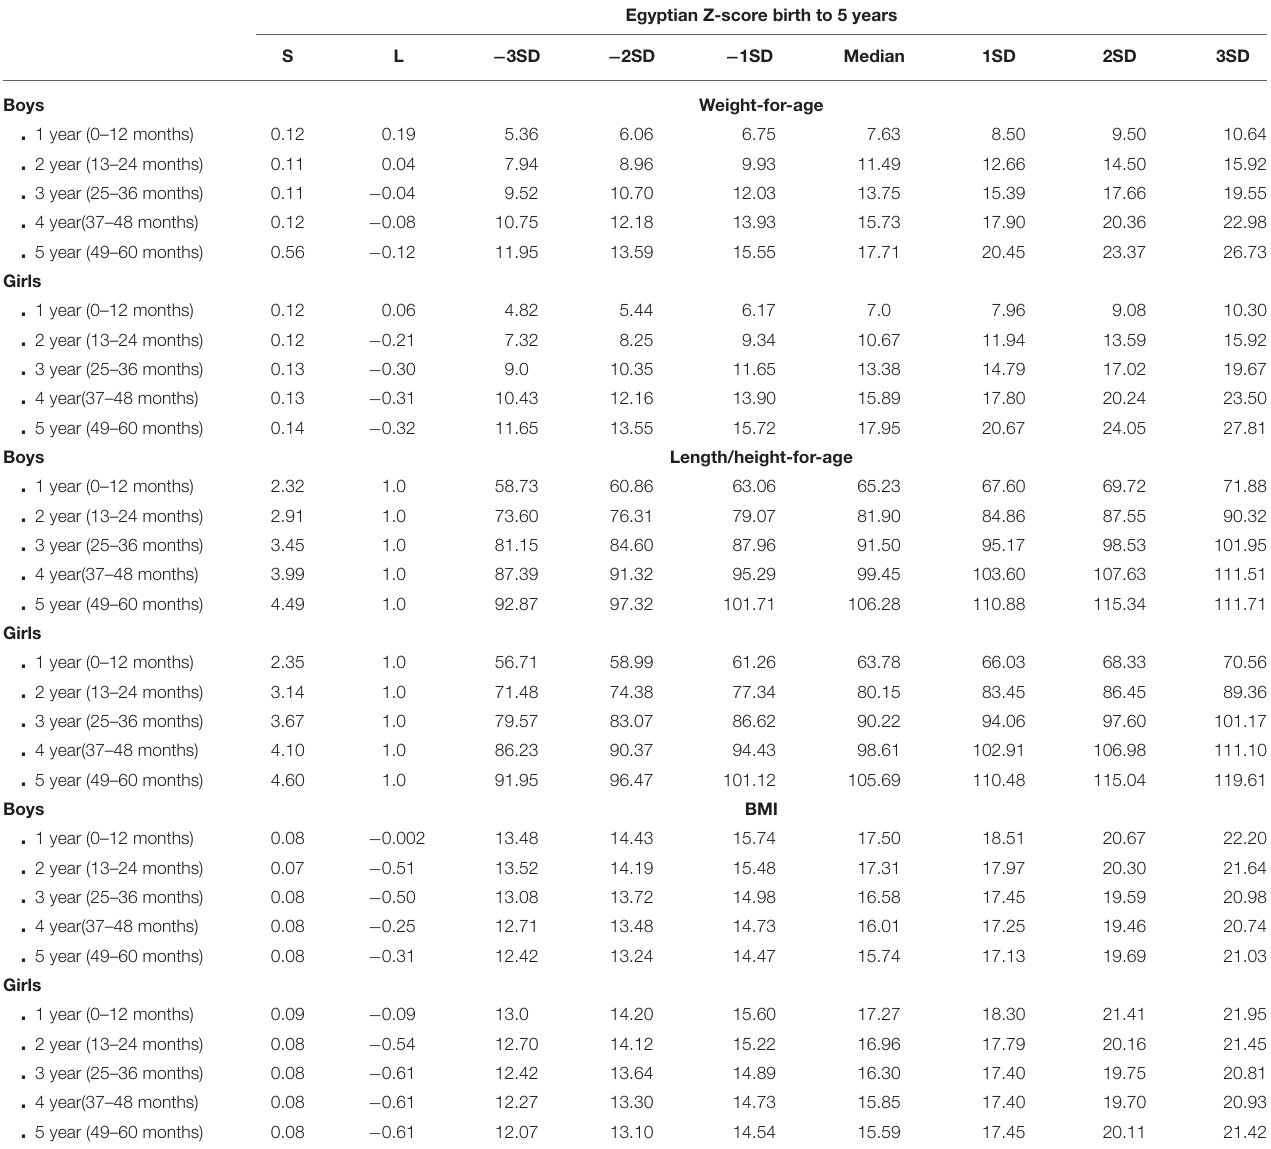
TABLE 2 | Egyptian L and S parameters and Z score weight-, Length/Height-, and BMI- for-age from birth up to 5 years.